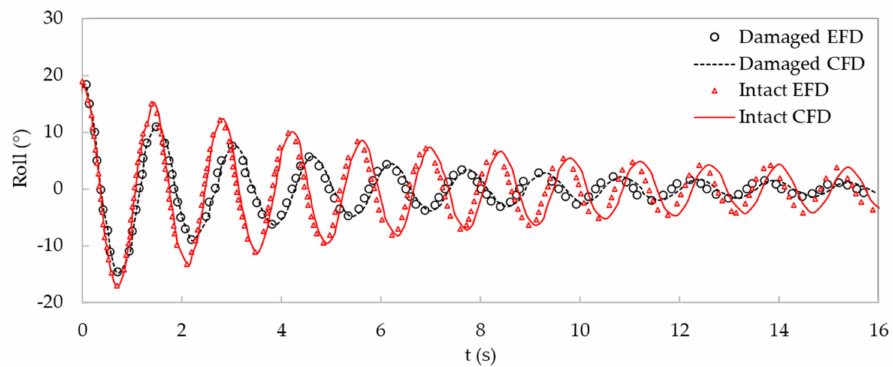
Figure 9. Comparison of the roll decay motion of the intact and damaged ships obtained by the experiment and the numerical simulations.